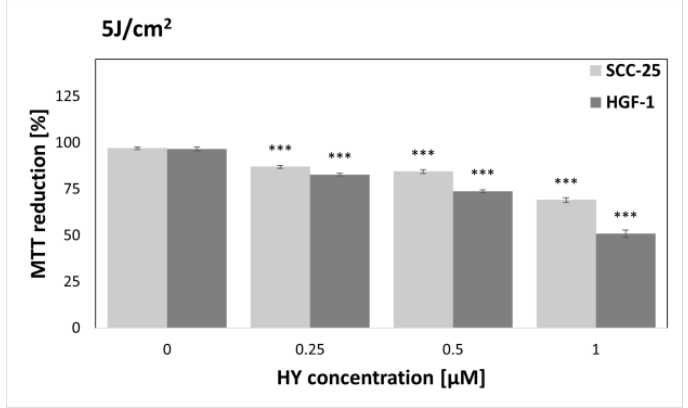
Figure 5. MTT reduction in the SCC-25 and HGF-1 lines for different HY concentrations: 0 µM, 0.25 µM, 0.5 µM, and 1 µM and light dose 2 J/cm 2 . The values represent the means ± SE. ** p < 0.05.